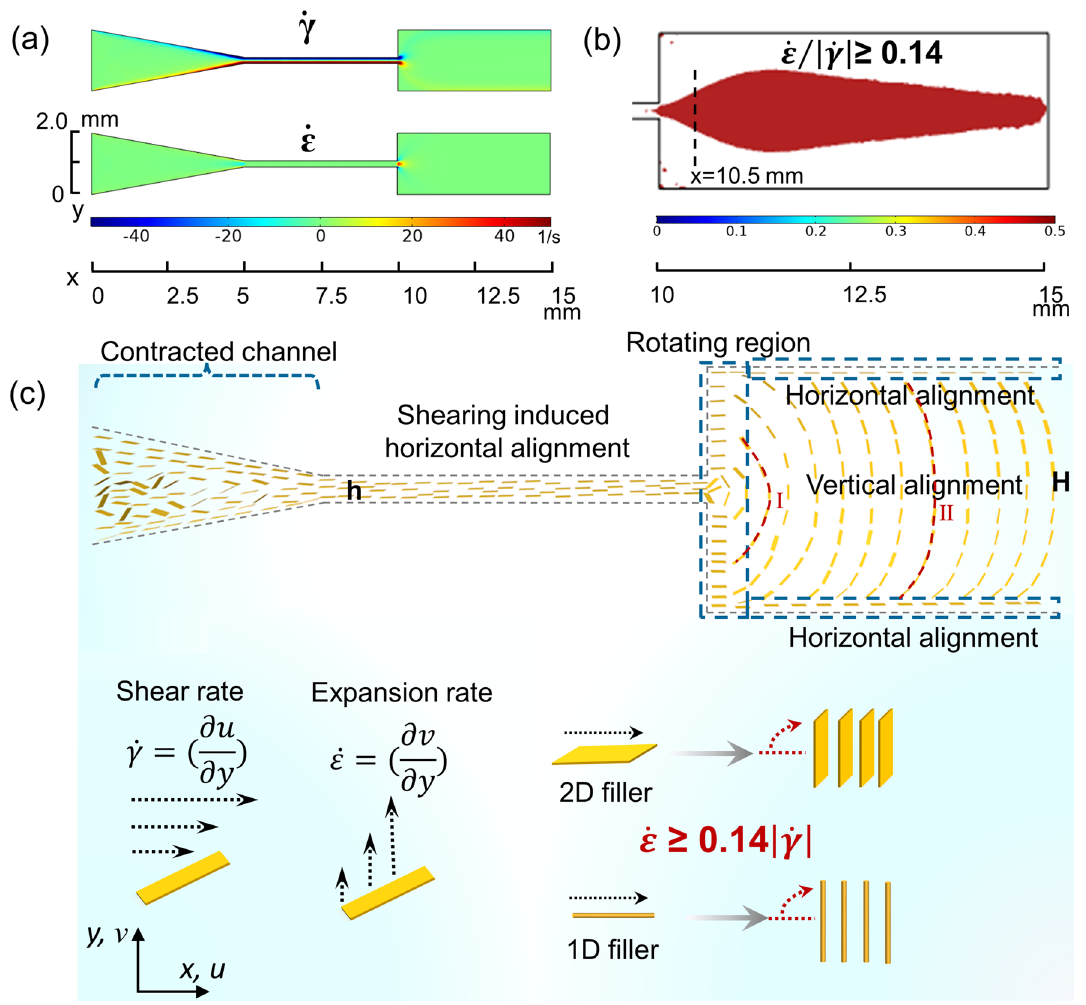
Fig. 3 Mechanism of vertical alignment in expansion flow. a, b CFD computed shear rate, expansion rate, and the ratio of expansion and shear rate. c Illustration of the rotating process of BN platelets from parallel to perpendicular to the flow